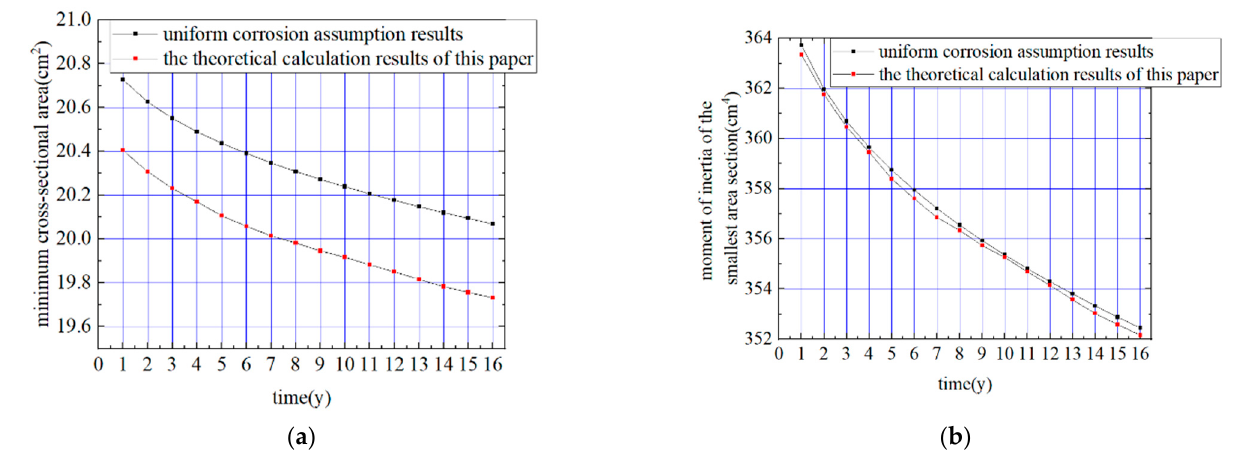
Figure 10. Comparison of simulation results with different calculation methods. ( a ) simulation results of the minimum cross-sectional area; ( b ) a simulation result of the minimum section’s inertia moment.